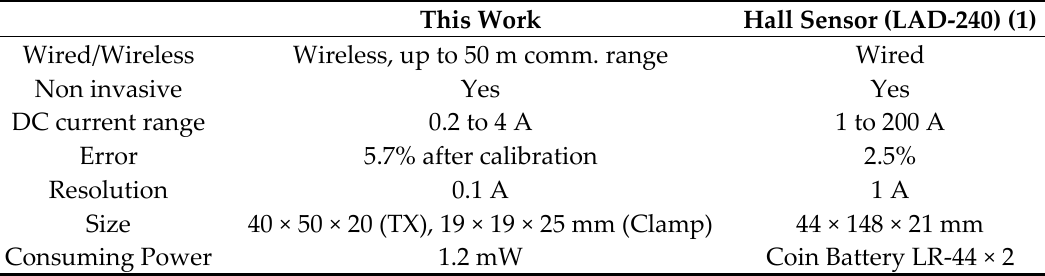
Table 1. Comparison Table of the DC current